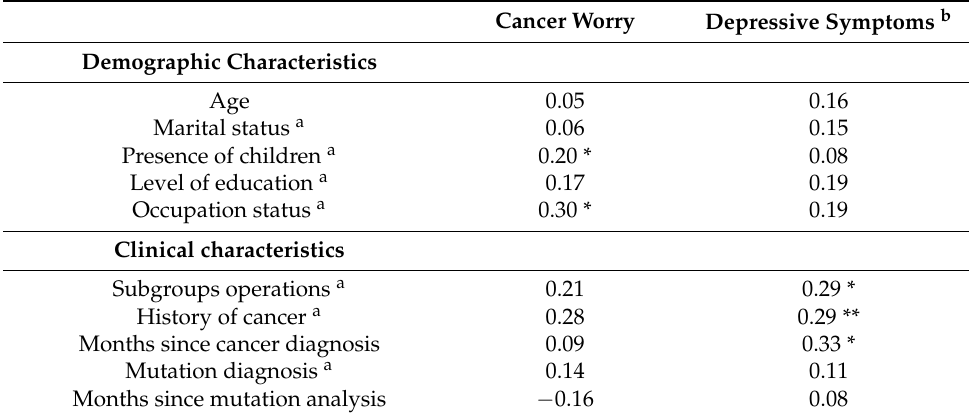
Table 4. Associations of sociodemographic variables, clinical characteristics, illness representations, and coping with cancer worry and depressive